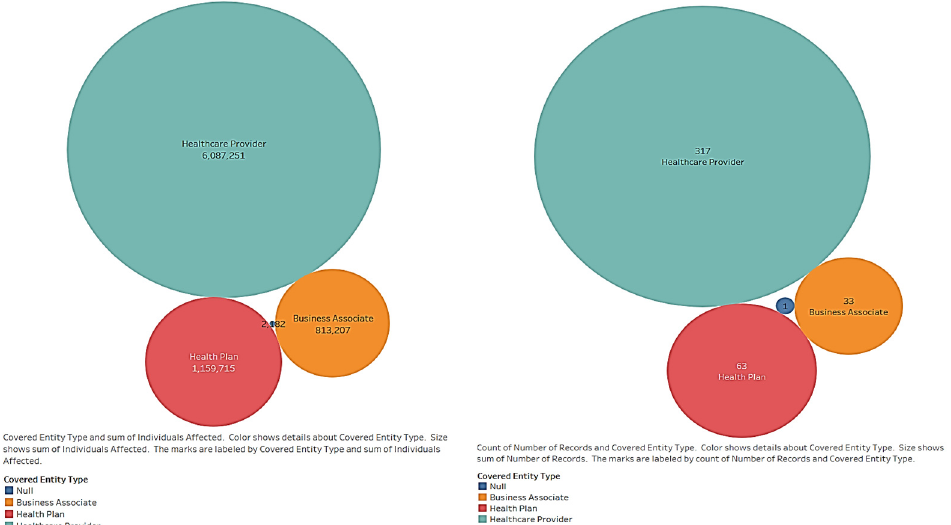
Figure 7. Distribution of affected individuals in entity types vs. data breach records distribution of entity types.